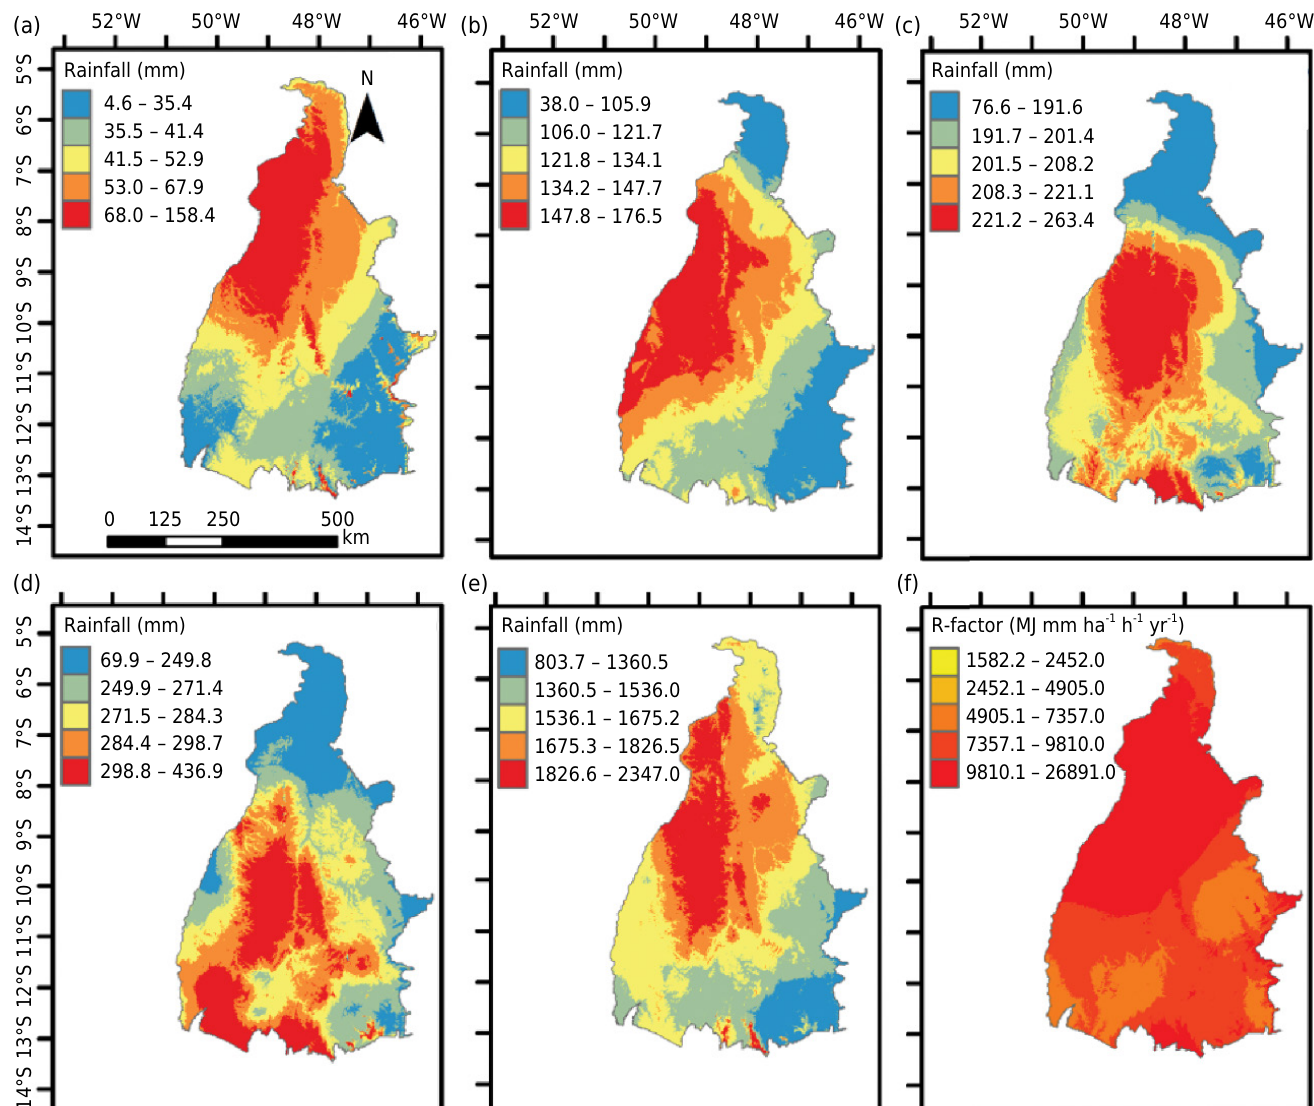
Figure 5. Maps generated by regression-kriging for rainfall estimated data for the quarter July-September (a), October (b), November (c), December (d), annual (e), and R-factor